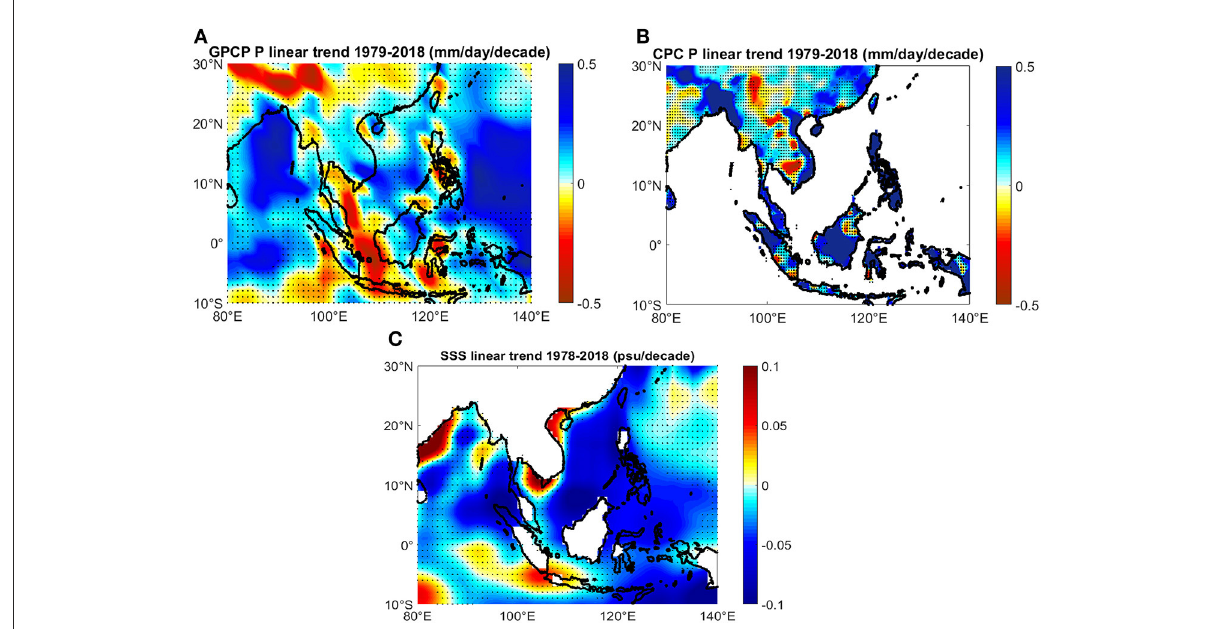
FIGURE6 Linear trends over 1979–2018 in (A) GPCP Precipitation; (B) CPC Precipitation; (C) En4 Near Surface Salinity. Regions where the linear trend is not significant at the 95% confidence interval are stippled.